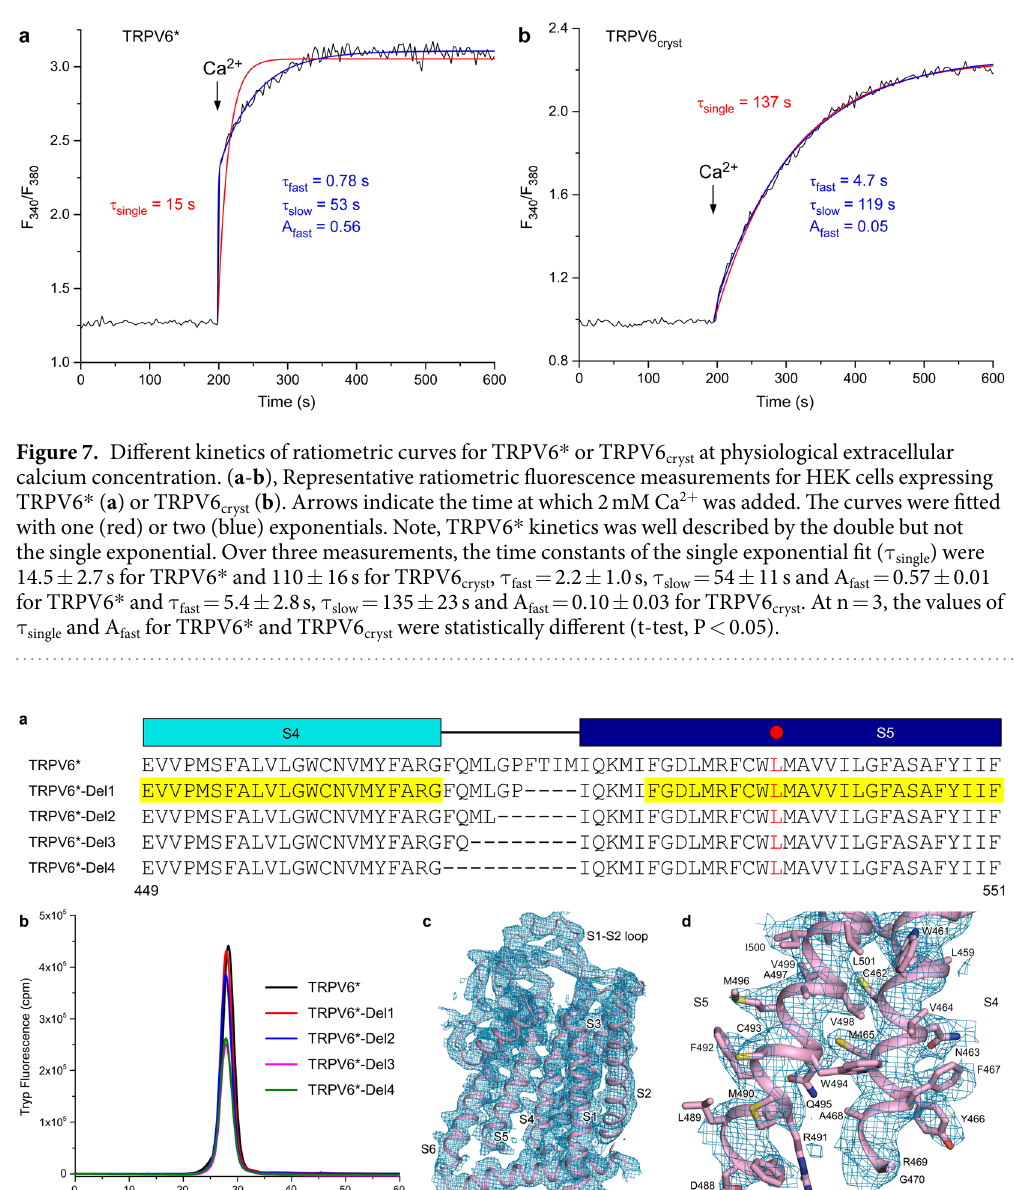
Crystallization and structure determination. Optimized crystals of purified TRPV6 * or TRPV6 * -del1 were grown in the same condition as crystals of TRPV6 cryst5 , which included a reservoir solution consisting of 20–24% PEG 350 MME, 50 mM NaCl and 50 mM Tris-HCl pH 8.0–8.5 in hanging drop configuration at 20 °C. Prior to crystallization using hanging drop method, the protein was subjected to ultracentrifugation (Ti100 rotor, 40000 rpm, 40 min, 4 °C) to remove the aggregated protein. Crystals were cryoprotected by serial transfer into the buffer composed of 100 mM NaCl, 100 mM Tris-HCl pH 8.2, 0.5 mM DDM and 50 mM ammonium formate, containing increasing concentration of PEG 350 MME, with maximum concentration of up to 33–36%, and then flash frozen in liquid nitrogen. To obtain crystals with Ca 2 + or Gd 3 + , protein was incubated with 10 mM CaCl 2 or 1 mM GdCl 3 , respectively, for at least 1 hour at 4 °C prior to crystallization.